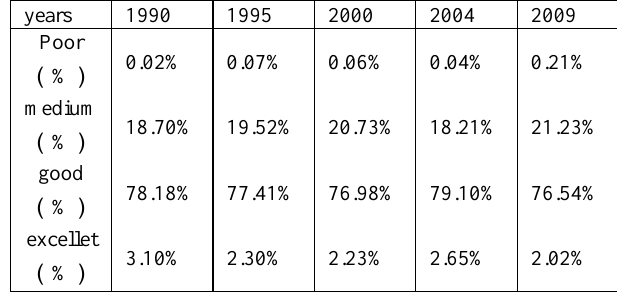
Table 5 Percentage of evaluation area of eco-environmental security in the study area from 1990 to 2009